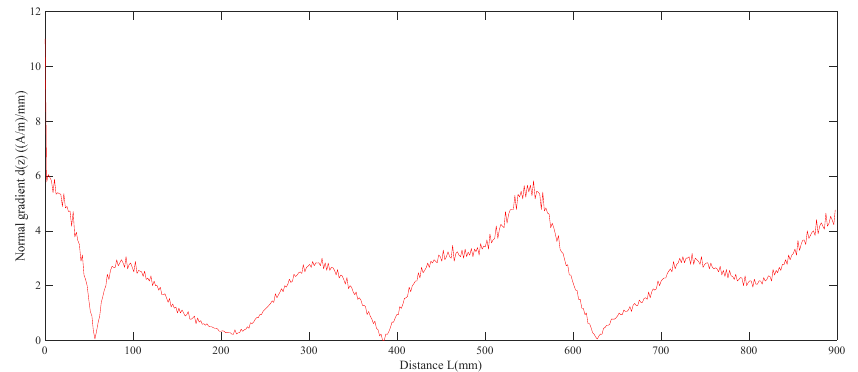
Figure 12. Normal gradient extremum dz.